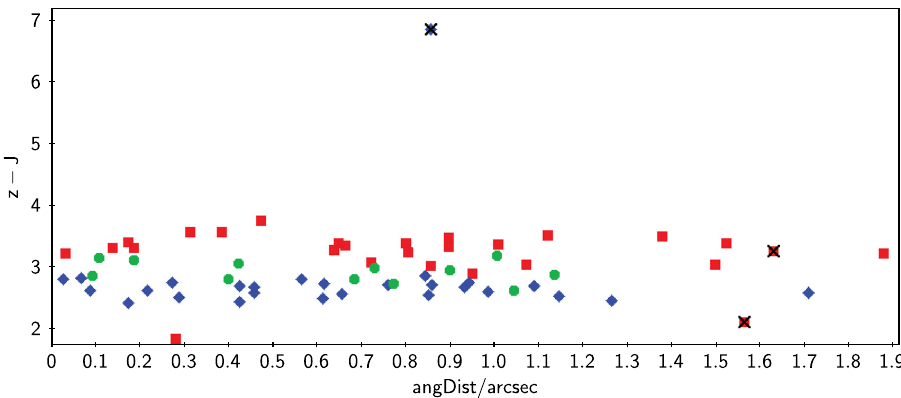
Figure 6: ( z J − ) Color index to the distance between the object and the match. Crosses indicate suspicious matches.